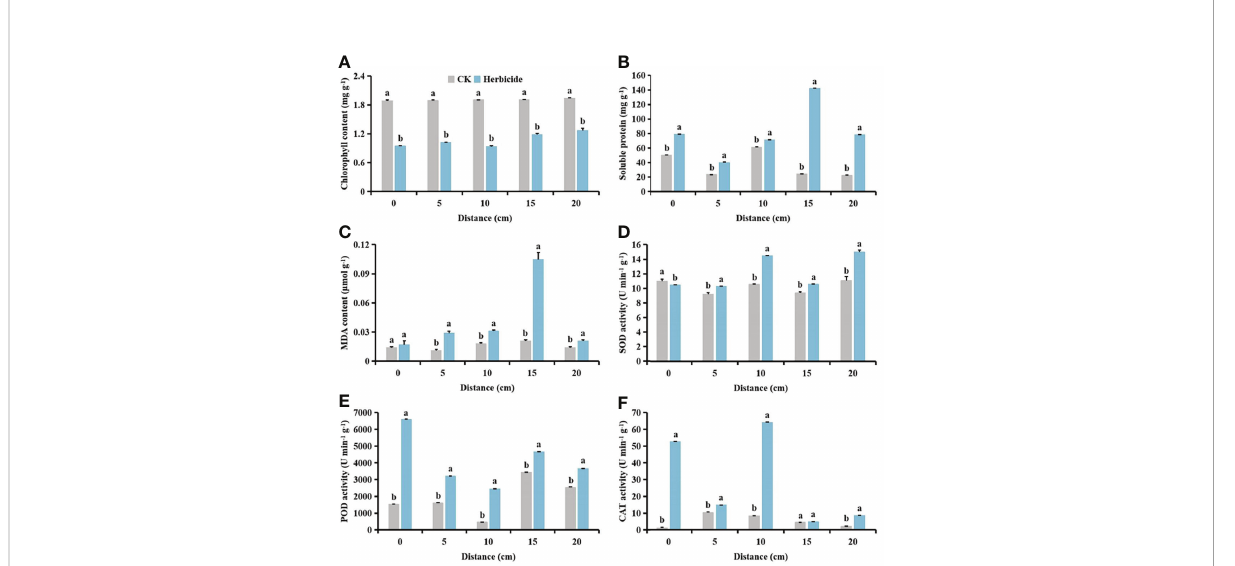
FIGURE 15 Effects of no herbicide application and spraying 0.015 g L -1 75% tri fl oxysulfuron + 4 g L -1 40% prometryn on (A) chlorophyll, (B) soluble protein and (C) malondialdehyde (MDA) content, and (D) superoxide dismutase (SOD), (E) peroxidase (POD) and (F) catalase (CAT) activities in Scirpus planiculmis at different spatial distribution distances. CK, no herbicide application; Herbicide, spraying 0.015 g L -1 75% tri fl oxysulfuron + 4 g L -1 40% prometryn. The mean value ± standard data were presented in the fi gure. Different alphabetical letters indicate the signi fi cant differences between CK and herbicide ( p